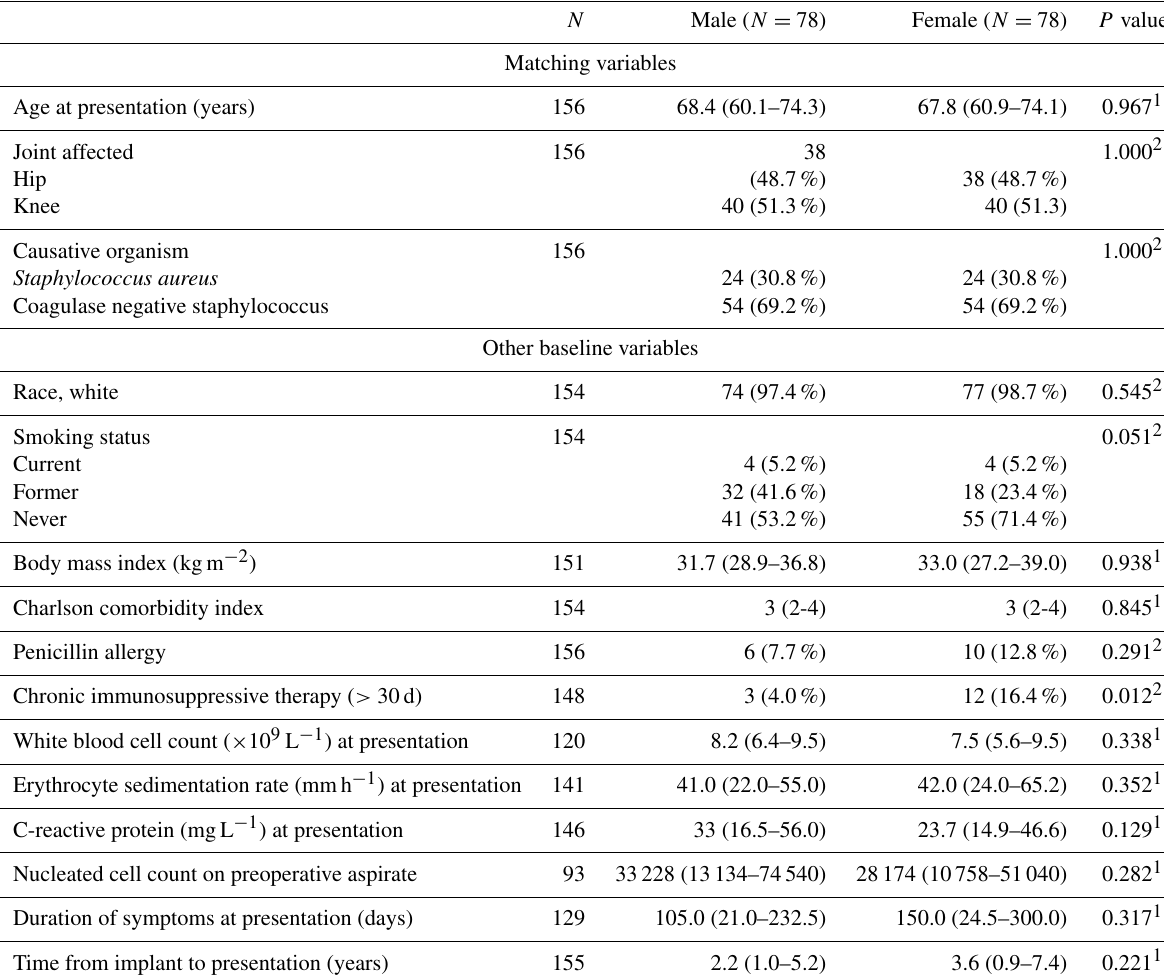
Table 1. Summary of baseline